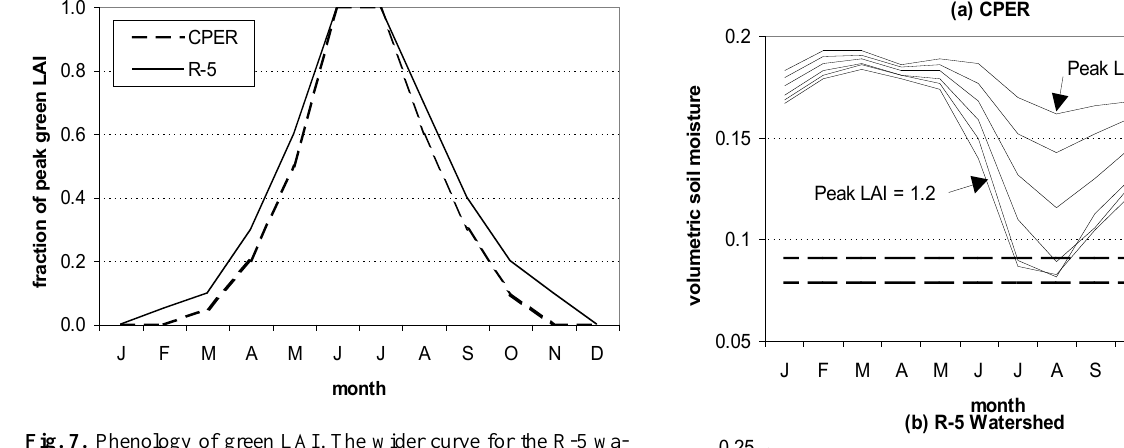
variation in saturated hydraulic conductivity at the R-5